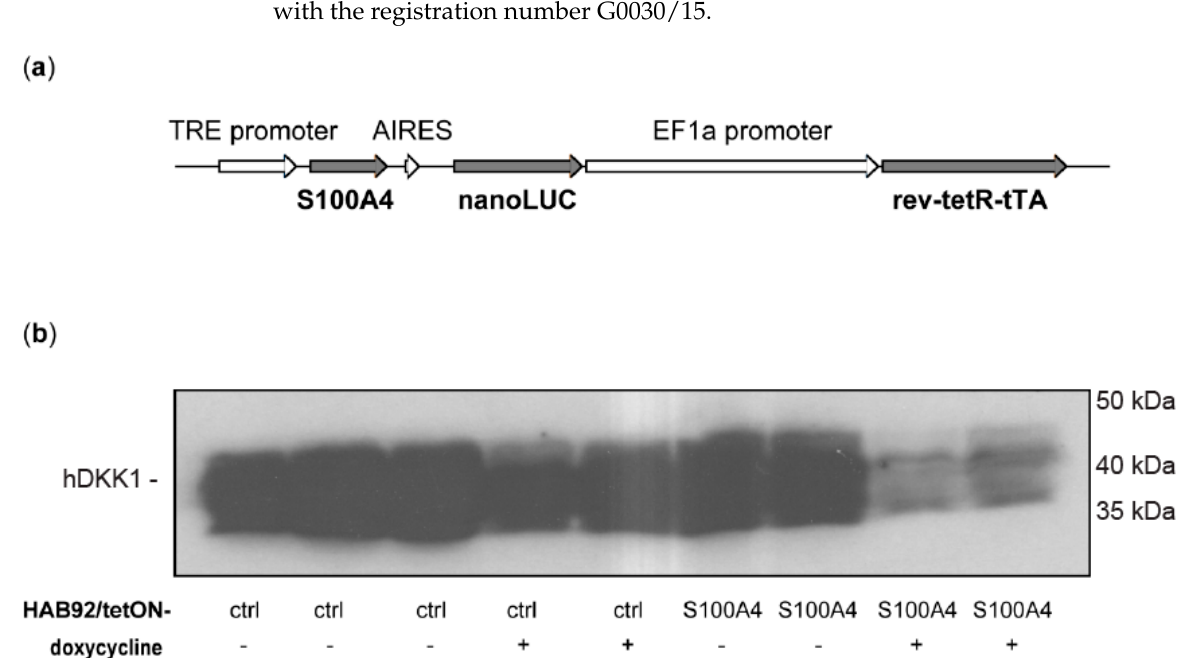
(Figure Figure S1m). Mice with